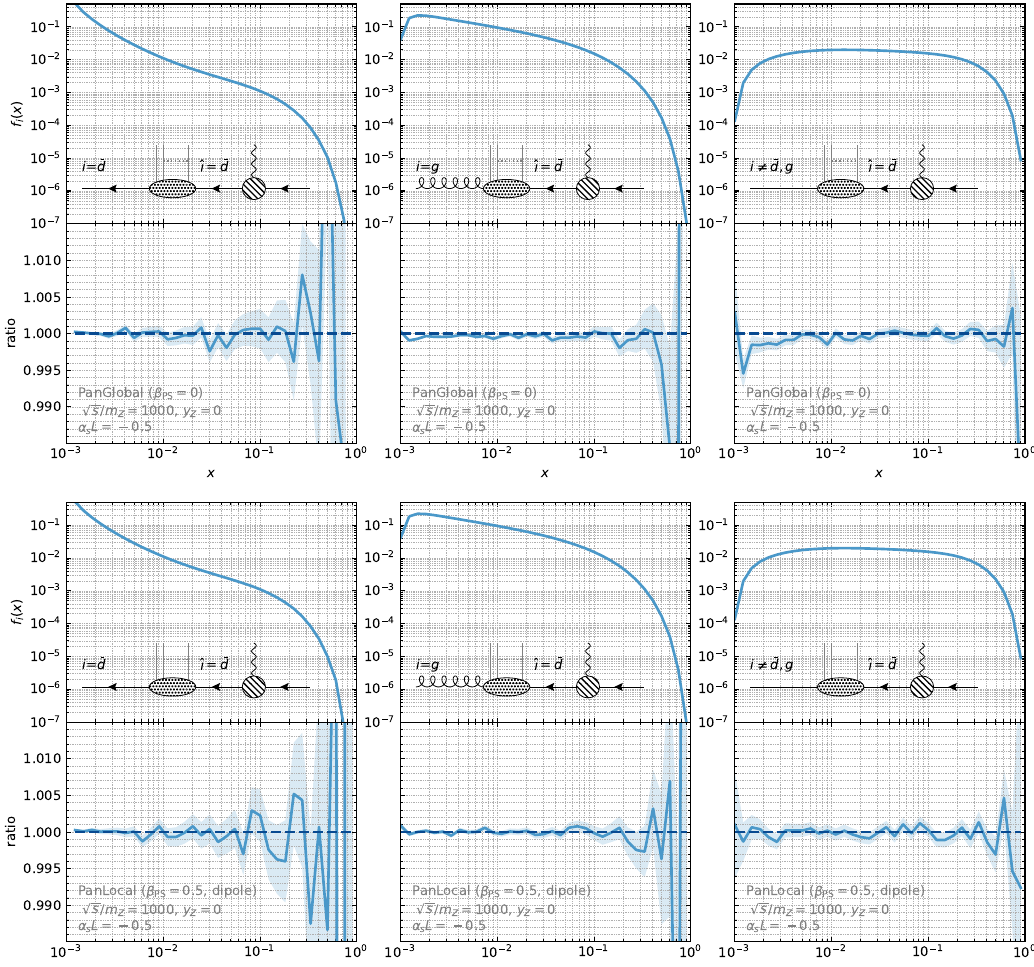
Figure 1. Ratio of the DGLAP evolution produced by the parton shower versus the DGLAP evolution as calculated with HOPPET. The results are shown as a function of the momentum fraction x carried by the parton extracted from the proton. The forward evolution in our HOPPET- based reference calculation is constrained to end with the ˆ ı = ¯ d flavour, such that it reflects the starting point of the (backwards-evolving) shower, which we take to be d ¯ d in this case. We work √ with y Z = 0 and s/m Z = 1000 , such that the maximal x fraction a parton can have is 0 . 001 . We take λ = α s L = − 0 . 5 . The three columns then show different extracted flavours i that led to this ˆ ı = ¯ d state, where we focus on the i = ¯ d (left), i = g (middle) and i 6 = { ¯ d, g } (right) cases. We show the PanGlobal shower with β ps = 0 (upper panels), and the PanLocal dipole shower with β ps = 0 . 5 (lower